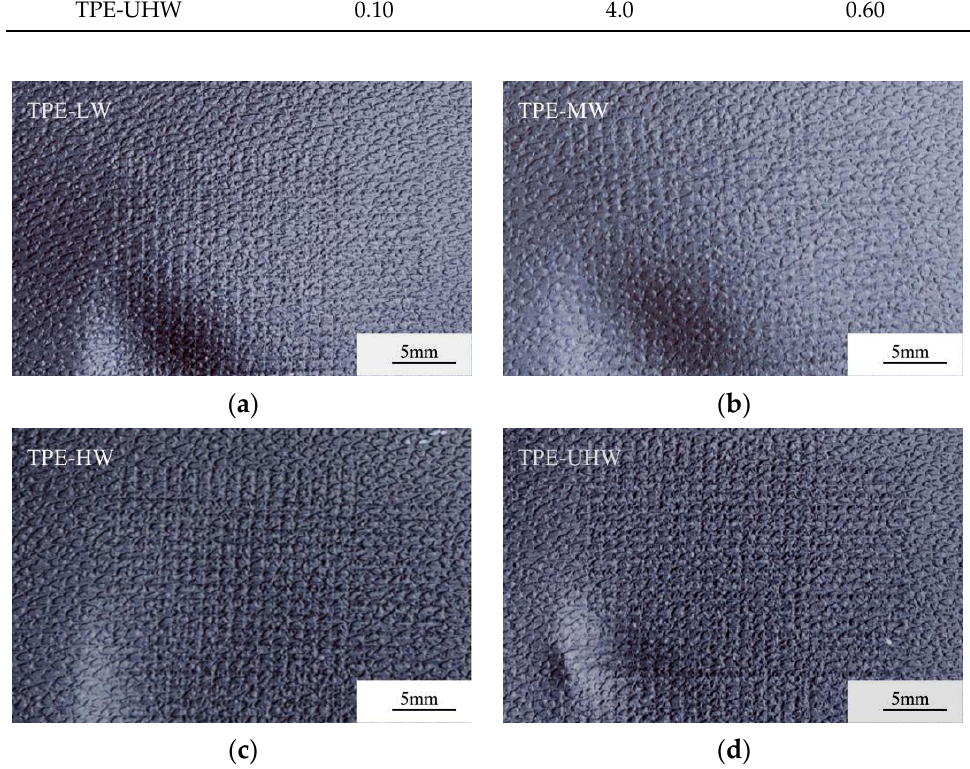
Figure 1. Samples after cross-scratch test of TPE prepared by SEBS with similar structure and various molecular weights. ( a ) TPE-LW; ( b ) TPE-MW; ( c ) TPE-HW; ( d ) TPE-UHW.